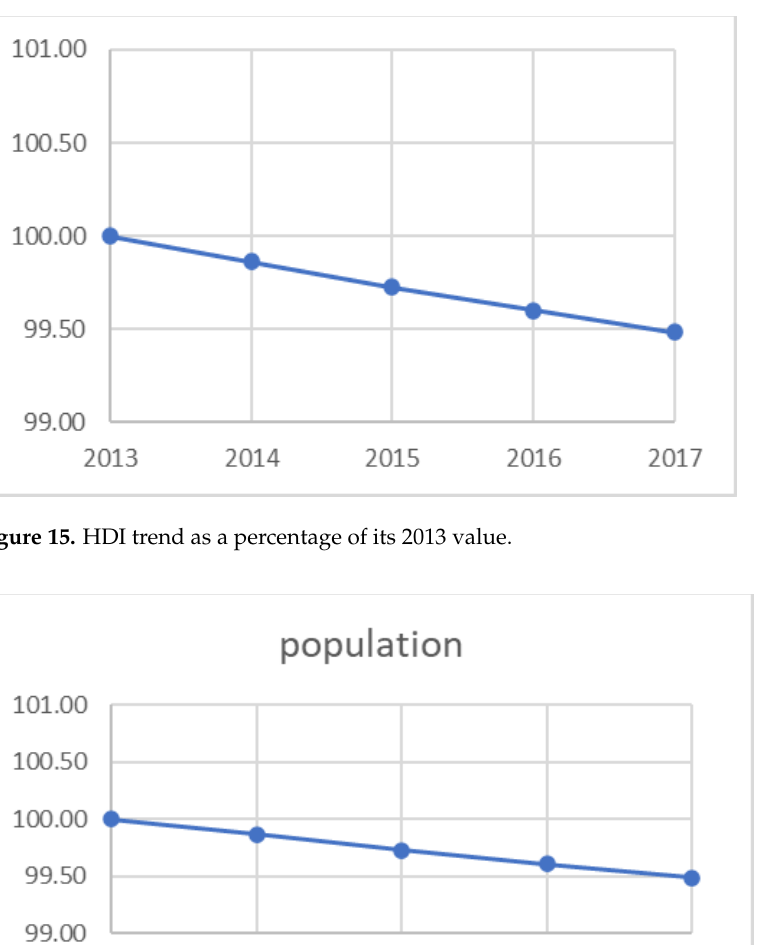
Figure 14. Extended exergy from 2013 to 2017. The 2013 value (1331917.46) is set to 100%.